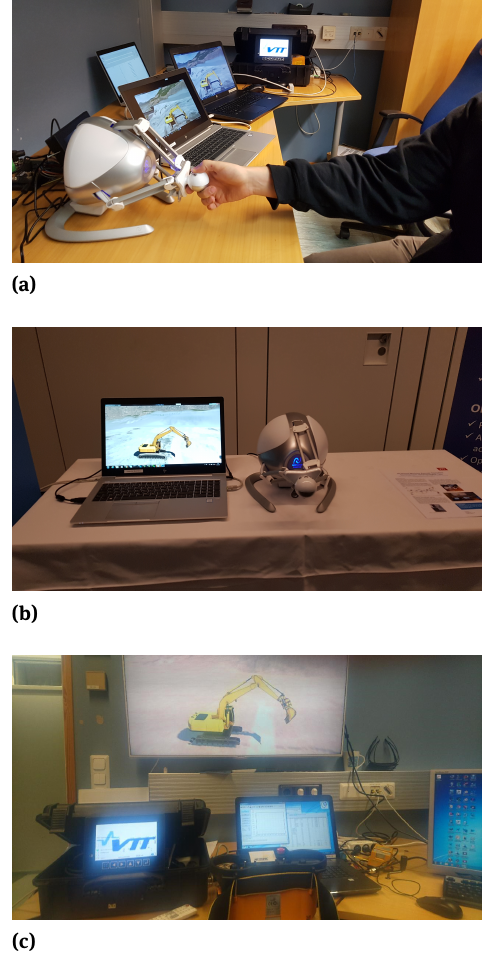
Figure 8: Demonstration of the haptic remote control: co-located system (a), the local site in Vantaa (b), and the remote site in Oulu